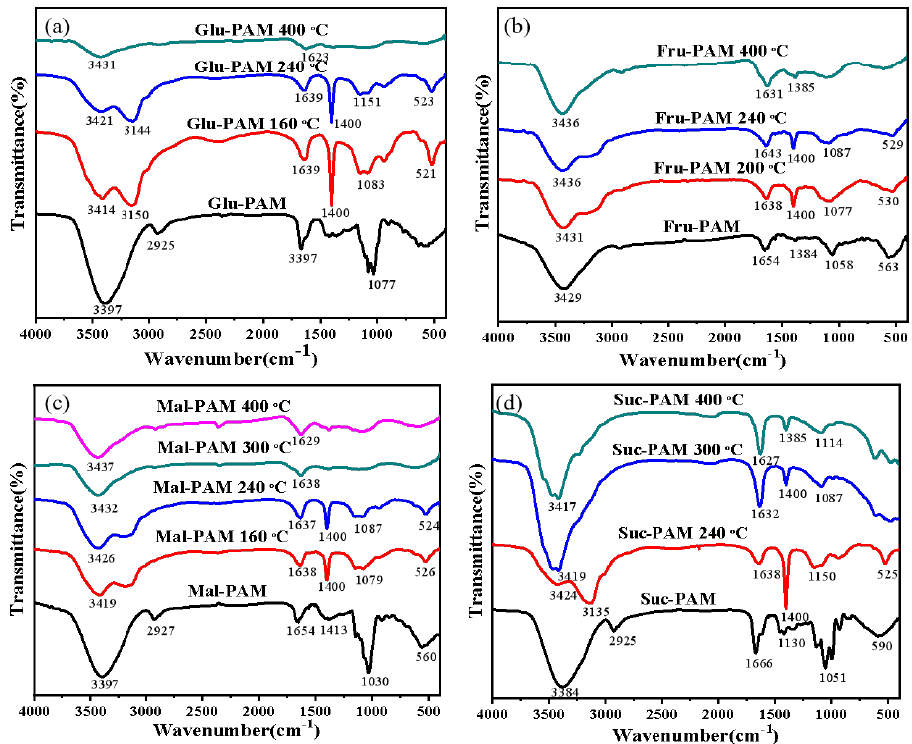
Figure 4. FTIR spectra of four sugar–PAM hydrogels treated at different temperatures. ( a ) Glu − PAM, ( b ) Fru − PAM, ( c ) Mal − PAM, ( d ) Suc − PAM.